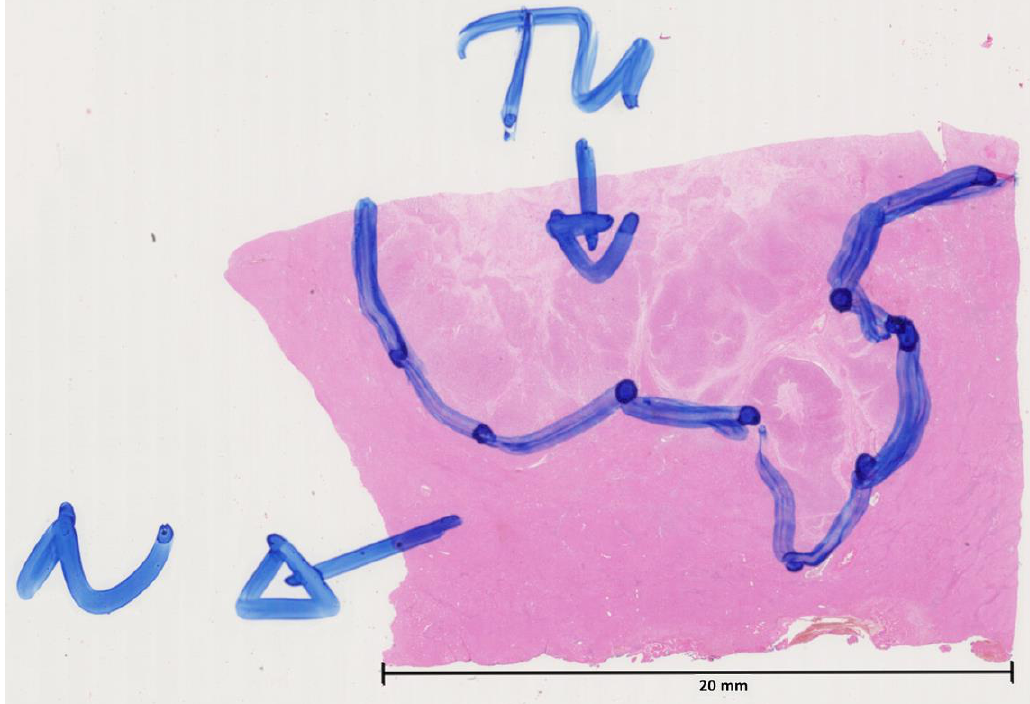
Figure 1. Digitised haematoxylin-and-eosin-stained tissue section with manually assigned cancer area (TU) and non-tumour (N) liver tissue by an independent